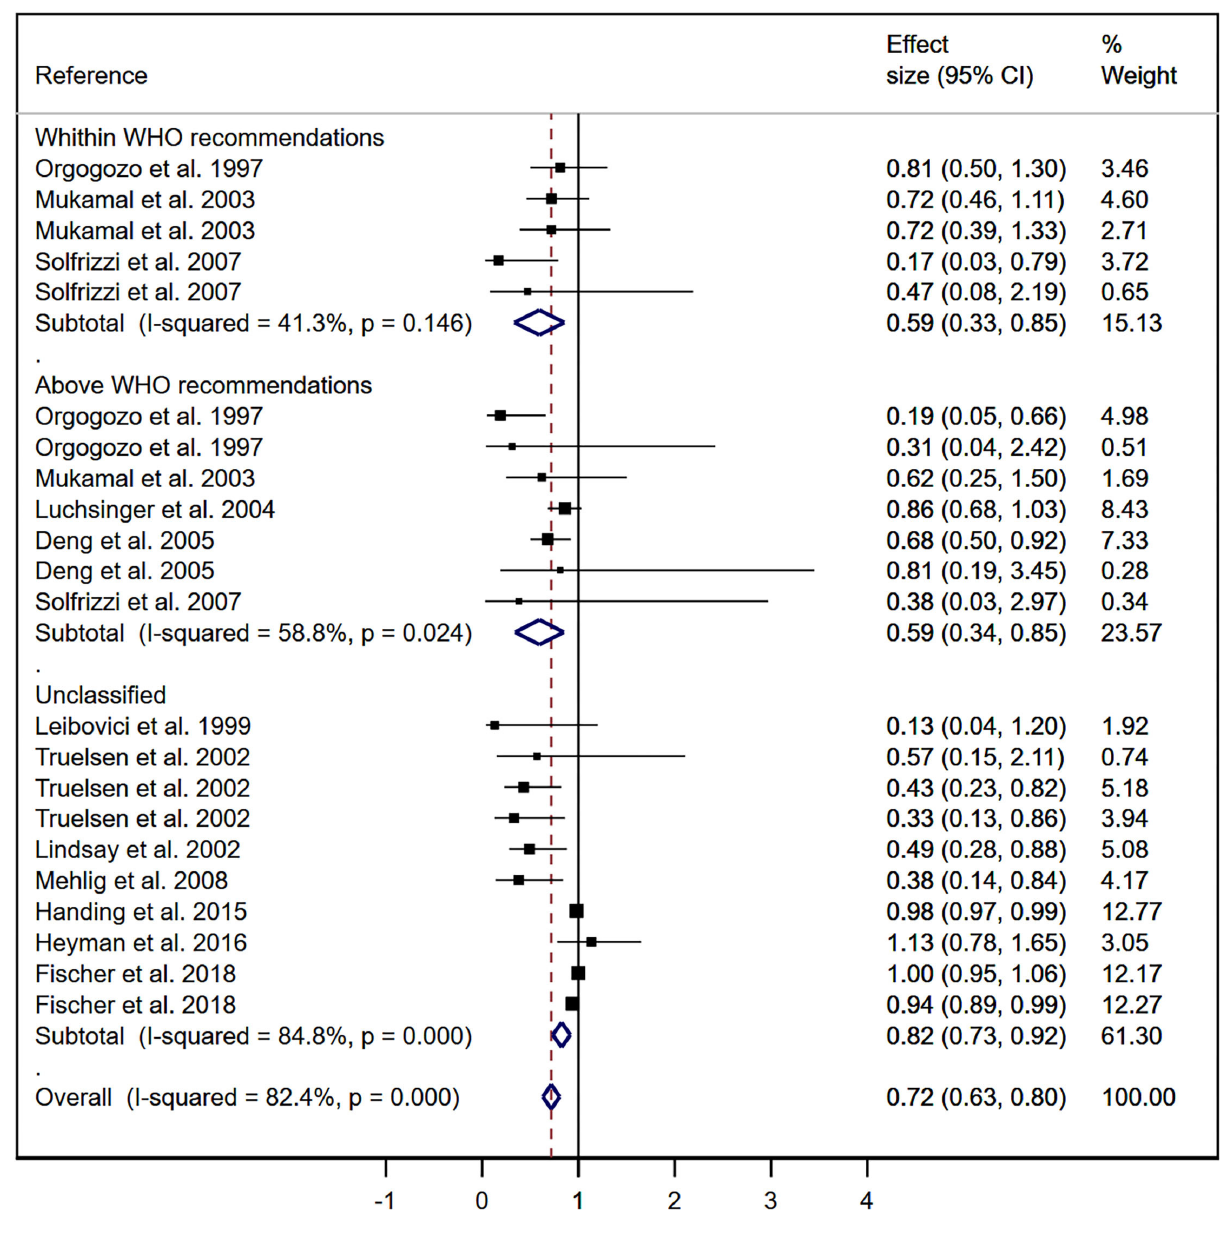
FIGURE 2 | Meta-analysis for the association of wine consumption and cognitive